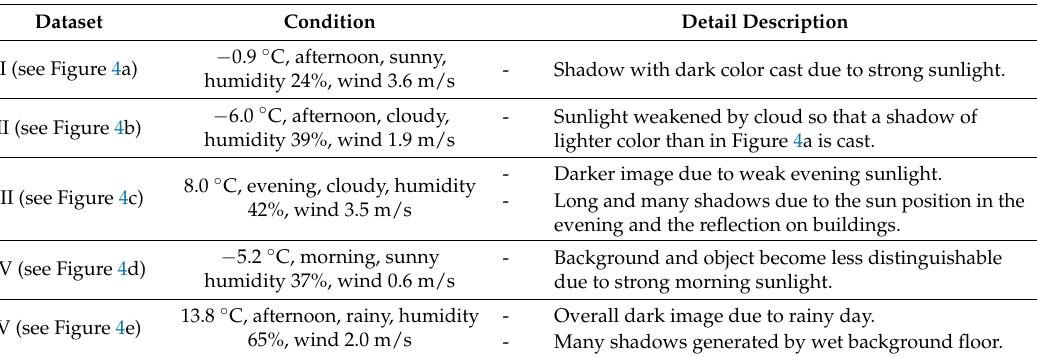
Table 3. Description of five datasets.